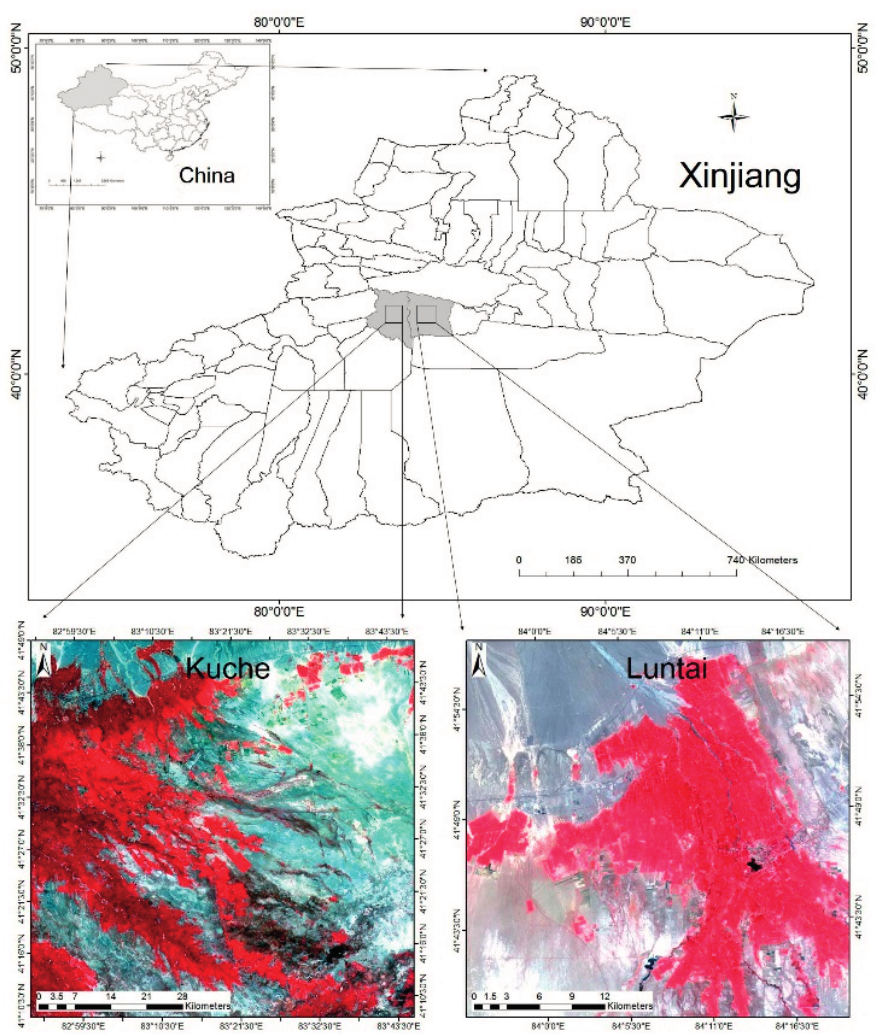
Figure 1. Locations of the study